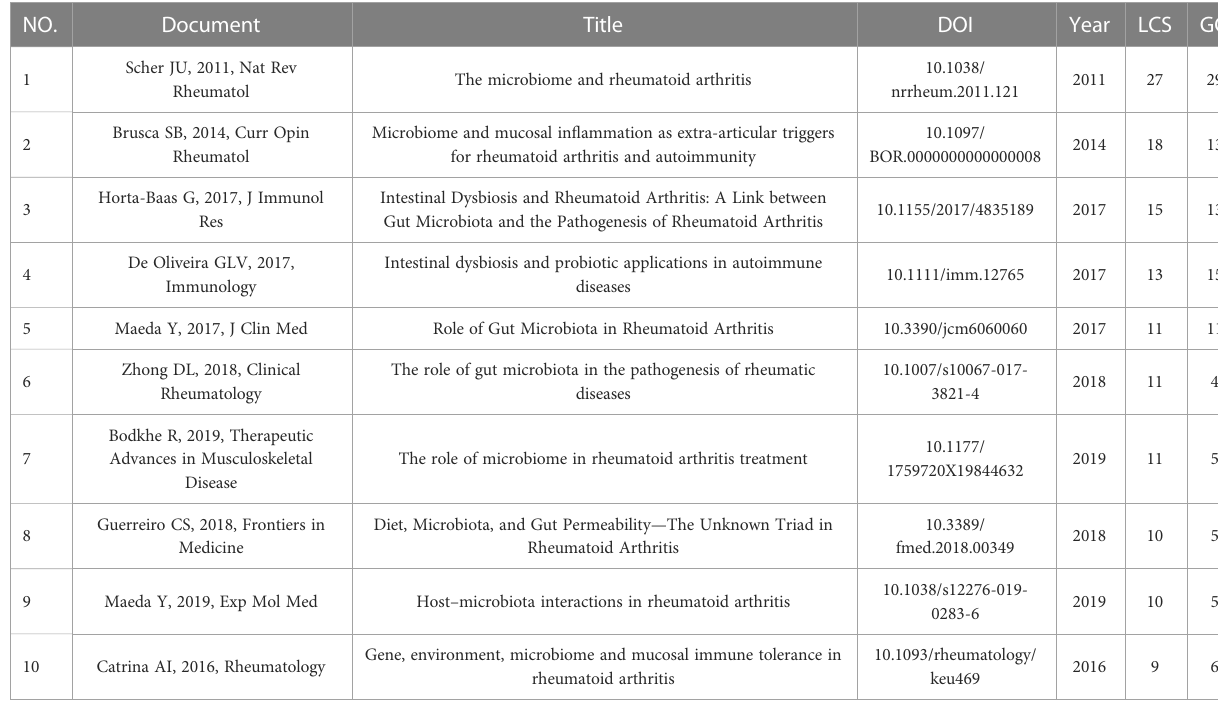
TABLE 6 The top 10 highly local cited review